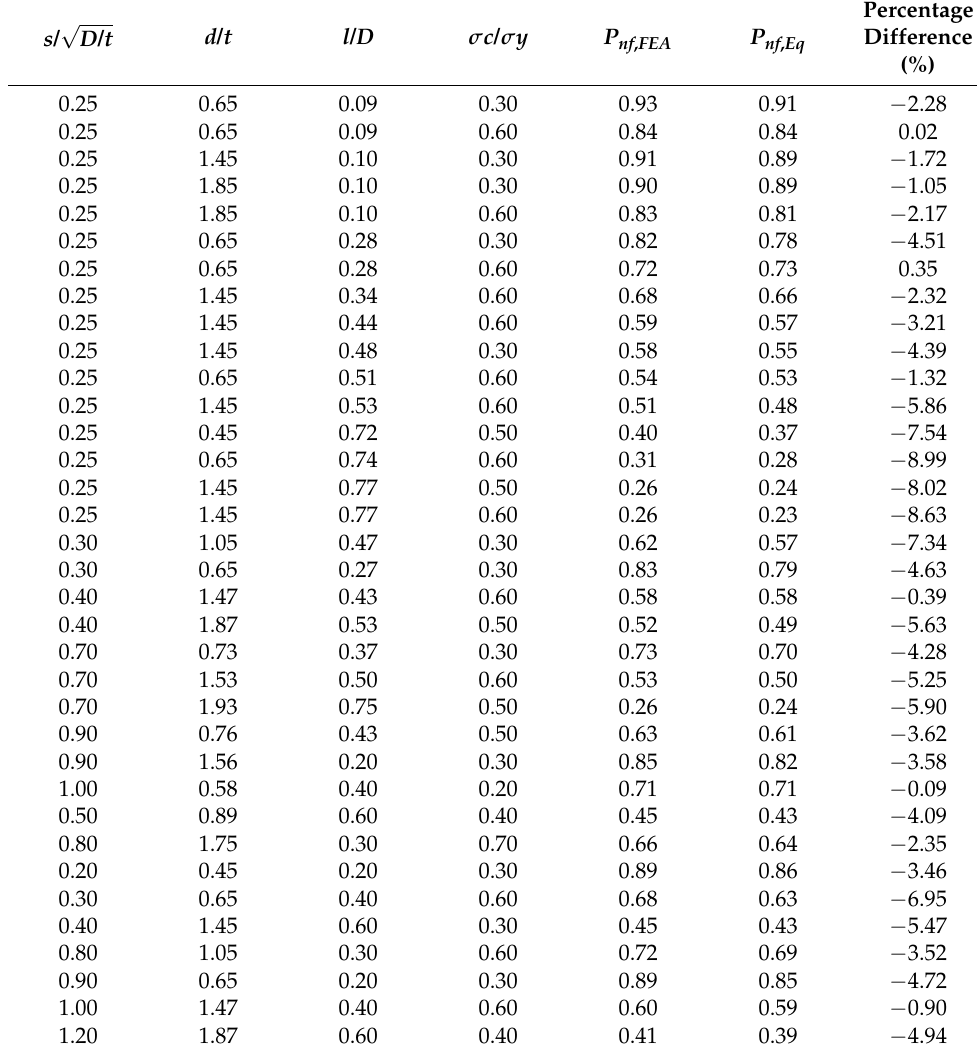
Table 9. Comparison of the failure pressure obtained using FEA and the empirical equation. √ s / D /